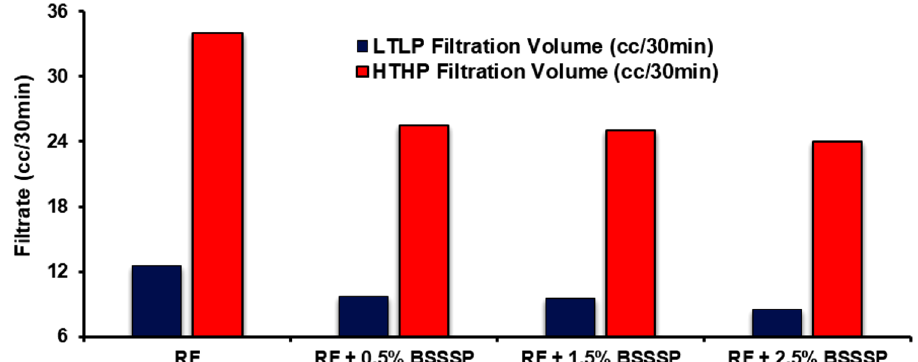
Fig. 8 Effect of BSSSP on the filtrate (fresh conditions; LTLP and HTHP